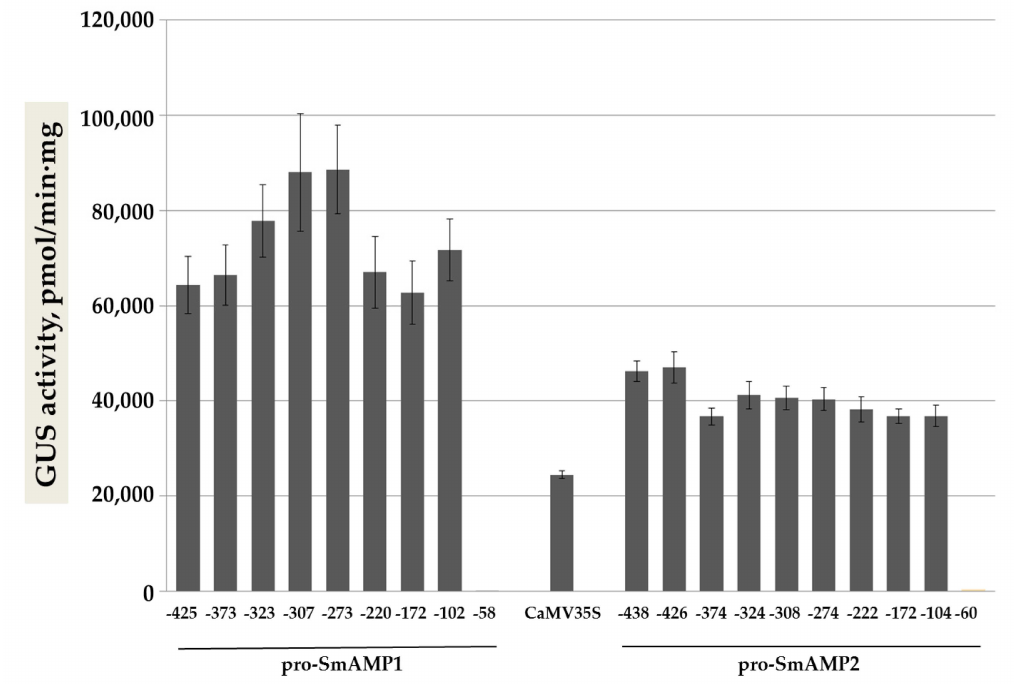
Figure3. ActivityoftheGUSreporterin N.benthamiana leavestransientlyexpressingvariousdeletionvariants ofthepro-SmAMP1andpro-SmAMP2promoters,alongsidetheCaMV35Sviralpromoter.Numbers indicate the length of the variants (in bp) from the TSS. Vertical lines show standard error, n = 44–60 for each construct. The plants were cultivated in a 16-h light / 8-h dark photoperiod. Deletion variants pro-SmAMP1 ( − 425 bp) and pro-SmAMP2 ( − 438 bp) were obtained in course of previous studies